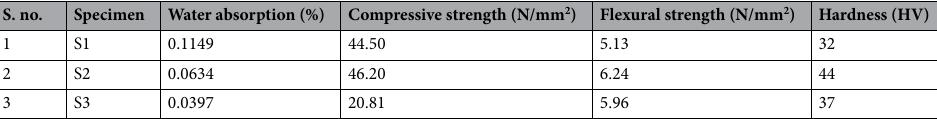
Table 5. Properties of the developed composites.